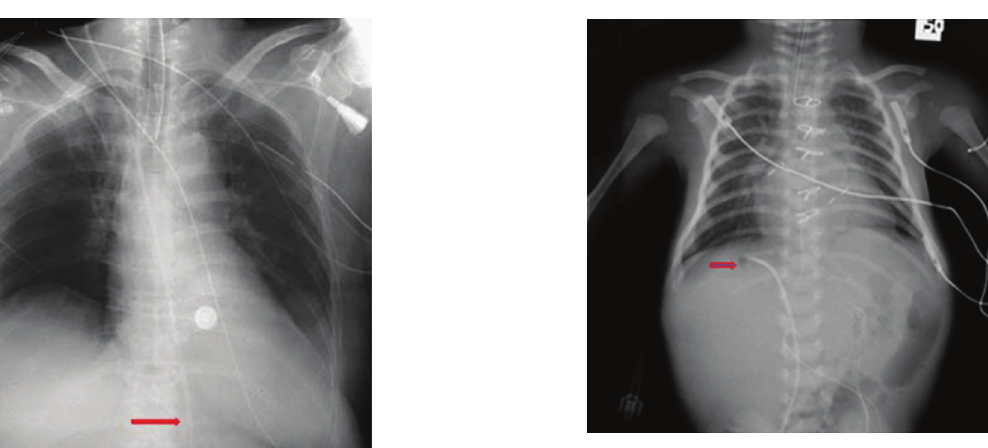
Figure 2: A CXR shows that an intravenous line placed via the right internal jugular vein as entered the azygos venous system.